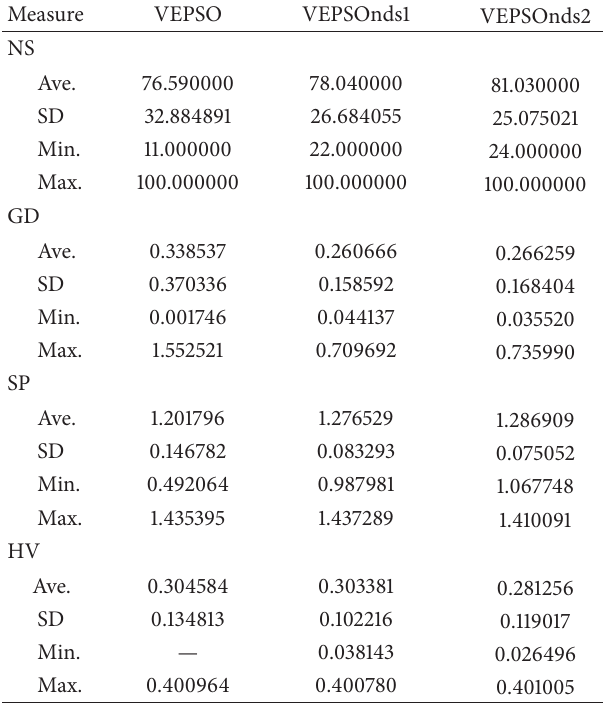
Table 5: Algorithm performance tested on ZDT6